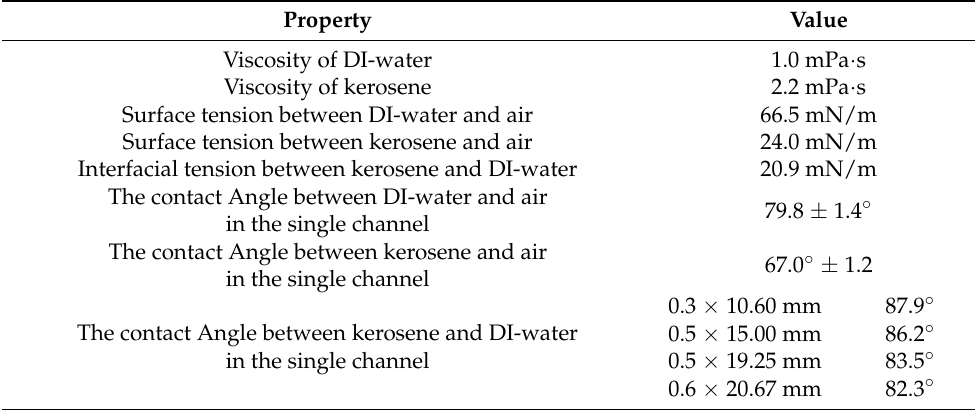
Table 1. Property parameters. Property